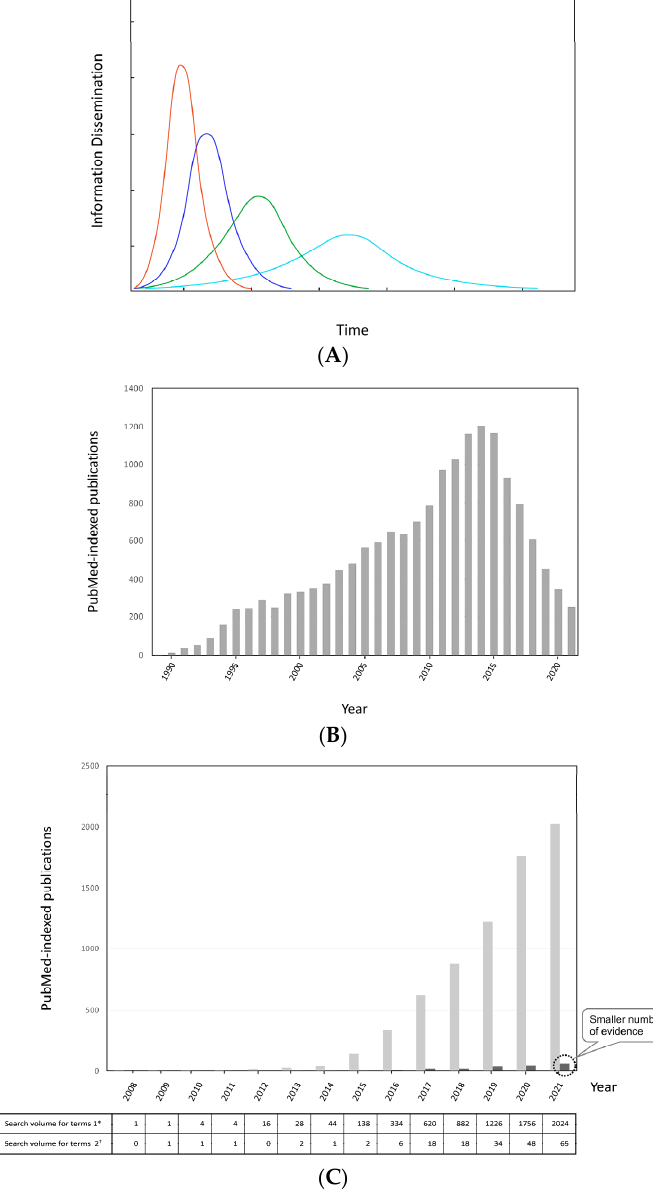
Figure 2. Information dissemination. ( A ) Simple model of rumor spreading. The stronger the correlation degree between medical information and real-world evidence is, the larger the spreading scale of medical information and faster the speed of dissemination are. Red line: The curve of information disemination when the credibility of scientific information was highest. Blue line: The curve of information disemination when the credibility of scientific information was 2nd higher. Green line: The curve of information disemination when the credibility of scientific information was tertiary. Light blue line: The curve of information disemination when the credibility of scientific information was lowest. ( B ) Annual research reports indexed in PubMed for the terms “hepatitis C” and “interferon”. ( C ) Annual research reports indexed in PubMed: “lung cancer and immune checkpoint inhibitor” vs. “thermal ablation and immune checkpoint inhibitor”. Note, search terms 1*: lung cancer and immune checkpoint inhibitor; search terms 2 † : thermal ablation and immune checkpoint inhibitor. Light grey: The number of publications per year with topics of lung cancer and immune checkpoint inhibitor. Dark grey: The number of publications per year with topics of thermal ablation and immune checkpoint